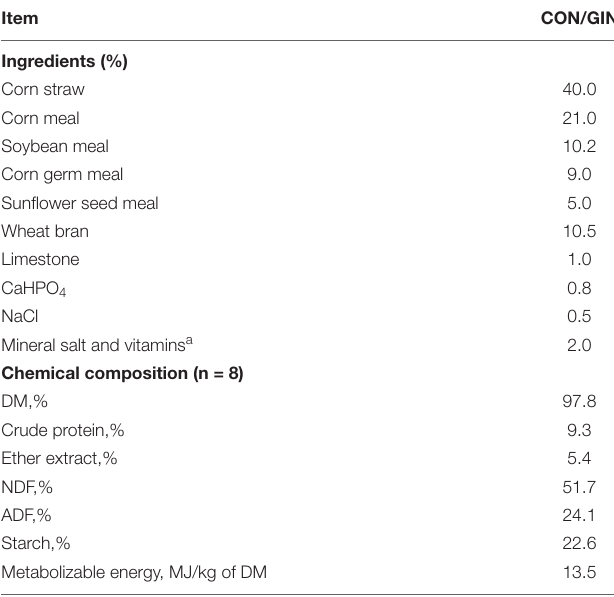
TABLE 1 | Ingredients and chemical composition of experimental